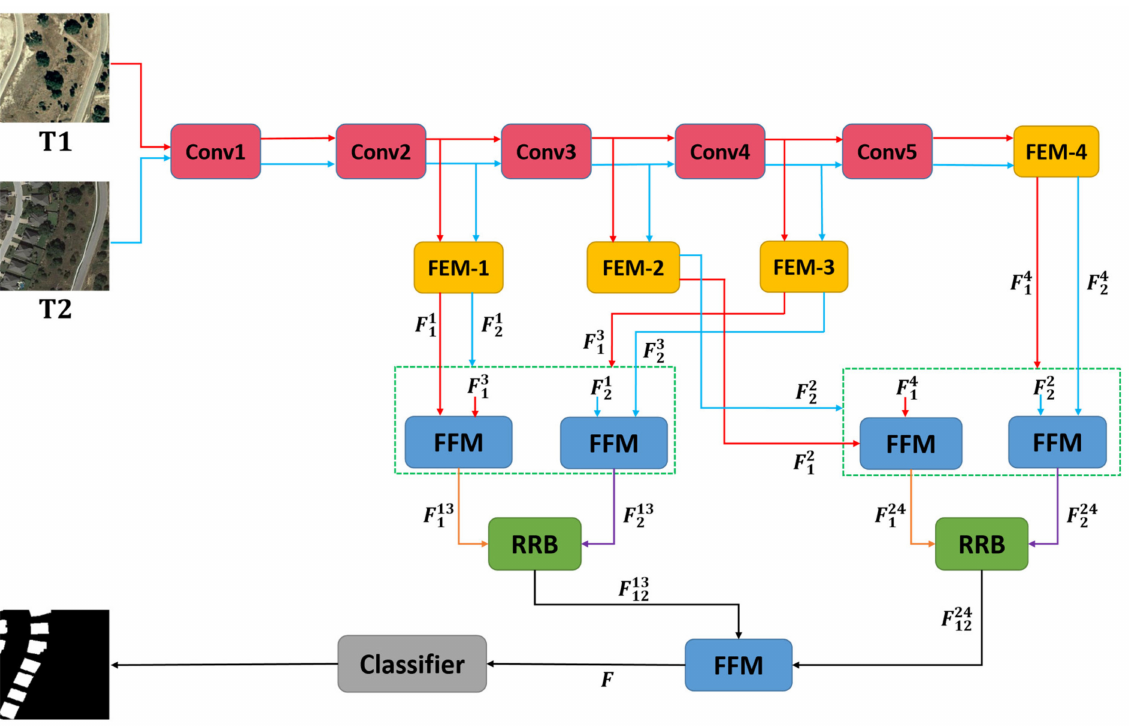
Figure 1. Architecture of the proposed MAFF-Net network. The green dotted box shows the cross- layer fusion strategy. the